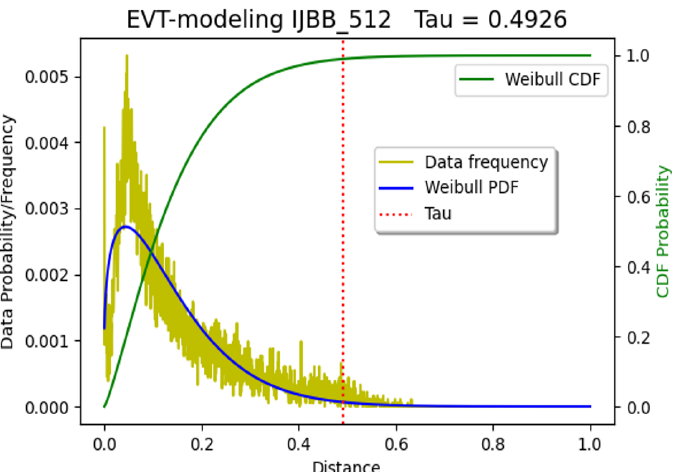
Figure 1. EVT-based Clustering Threshold Selection. We prove that nearest-neighbor distances and valid cluster link distances will follow an EVT distribution, and show how that leads to a good threshold selection for clustering. Yellow shows the data frequency histrogram, blue the probability density function, and green the cumulative density fit of a Weibull distribution to the approximate nearest-neighbor distance for IJB-B (protocol 512, see Section 5). While noisy, it is a good fit and supports choosing the threshold τ r / τ w at for the Cumulative Distribution Function (CDF) of the Weibull for 99%